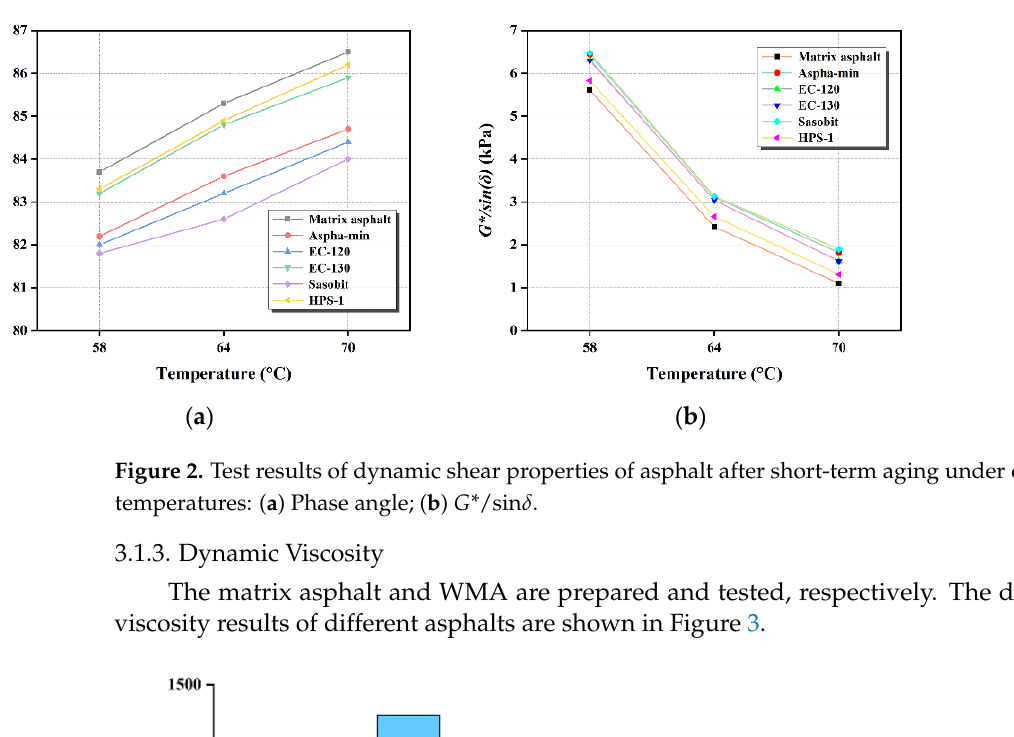
Figure 2. Test results of dynamic shear properties of asphalt after short-term aging under different temperatures: ( a ) Phase angle; ( b ) G* /sin δ .